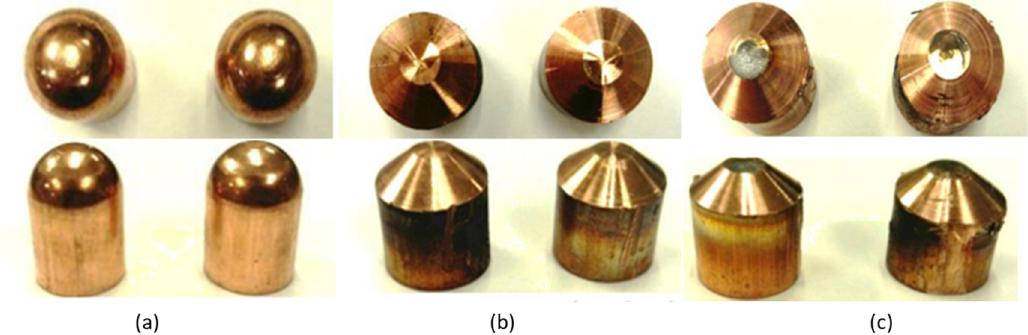
Figure 3. Evolution of the state of the electrodes. ( a ) Type F electrode before milling. ( b ) Type F electrode after good milling. ( c ) F-type electrode after poor milling.